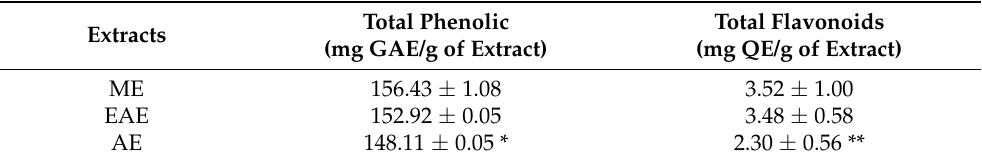
Table 1. Total phenolic and flavonoid contents of the methanol extract (ME) of P. lentiscus L. distilled leaves and its ethyl acetate (EAE) and aqueous (AE) fractions.